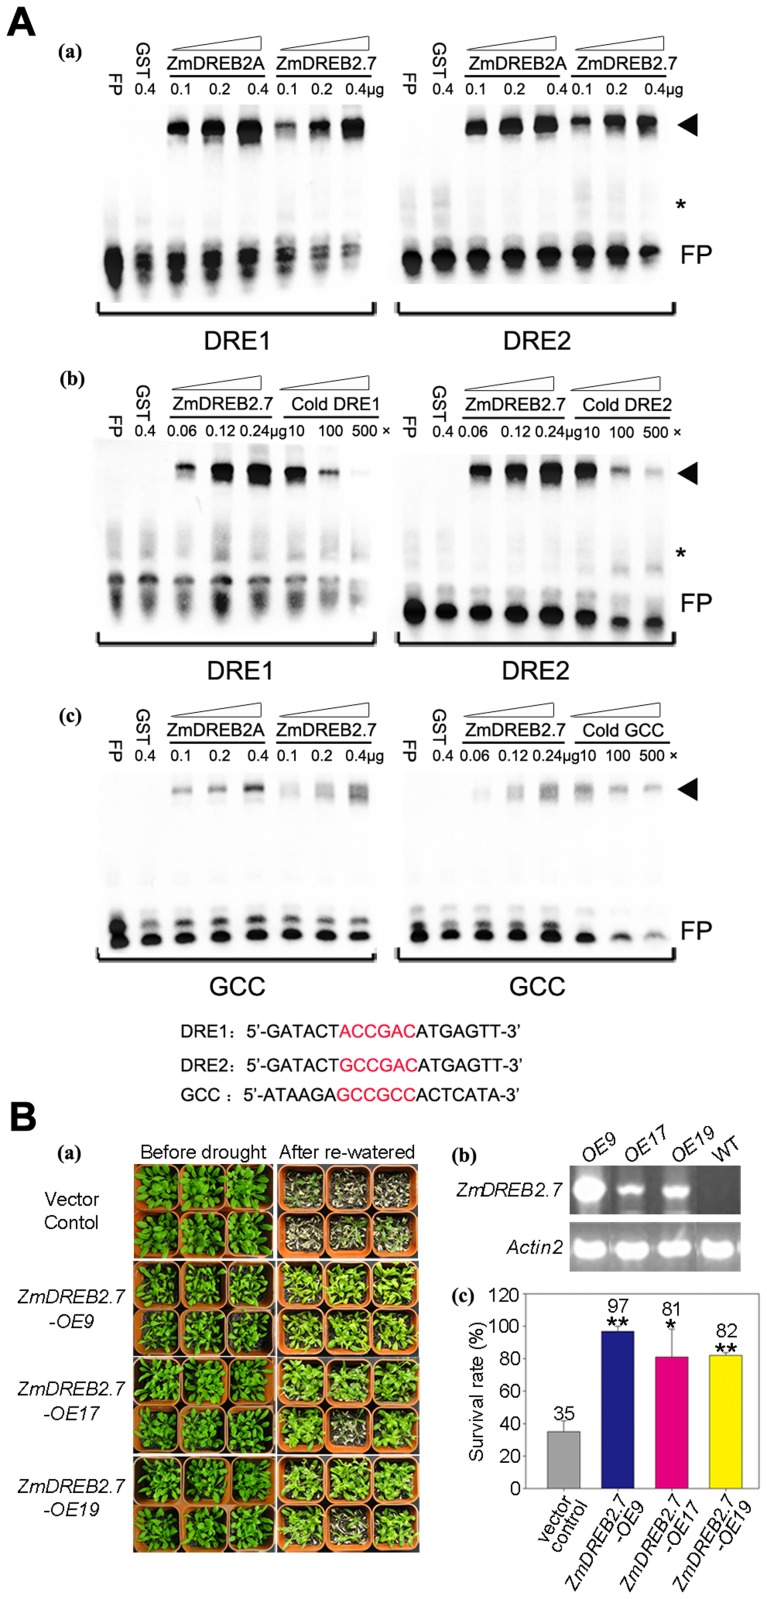
DNA binding analysis of ZmDREB2.7 and drought stress tolerance of 35S:ZmDREB2.7 transgenic Arabidopsis plants.(A) (a) Dosage-dependent binding of GST-ZmDREB2.7 to DRE1 and DRE2 elements. GST-ZmDREB2.1/2A was used as a positive control. (b) Competitive DNA binding assay of ZmDREB2.7 with DRE1 and DRE2 sequences. 10-, 100-, 500-fold excess amounts of the cold probe were used to compete for the binding of ZmDREB2.7 protein to the labeled probe. (c) The binding assay of GST-ZmDREB2.7 with a GCC-box. The sequences of the three kinds of DNA sequences are listed. Red letters indicate the core sequences. DNA-protein complexes are indicated by arrows; “*” indicates nonspecific bands; “FP” indicates unbound free probes. (B) (a) Drought tolerance of transgenic 35S:ZmDREB2.7 Arabidopsis plants. Photographs were taken both before and after the drought treatment followed by 6 days rewatering. Vector-transformed plants and ZmDREB2.7-OE9, ZmDREB2.7-OE17 and ZmDREB2.7-OE19 transgenic plants were compared. (b) RT-PCR analysis of transcript levels in the three lines of the 35S:ZmDREB2.7 transgenic plants. (c) Statistical analysis of survival rates after the drought-stress treatment. The average survival rates and standard errors were calculated from three independent experiments. Bars with asterisks indicate lines that had significantly higher survival rates than the vector-transformed plants (t-test, *p<0.05, **p<0.01).